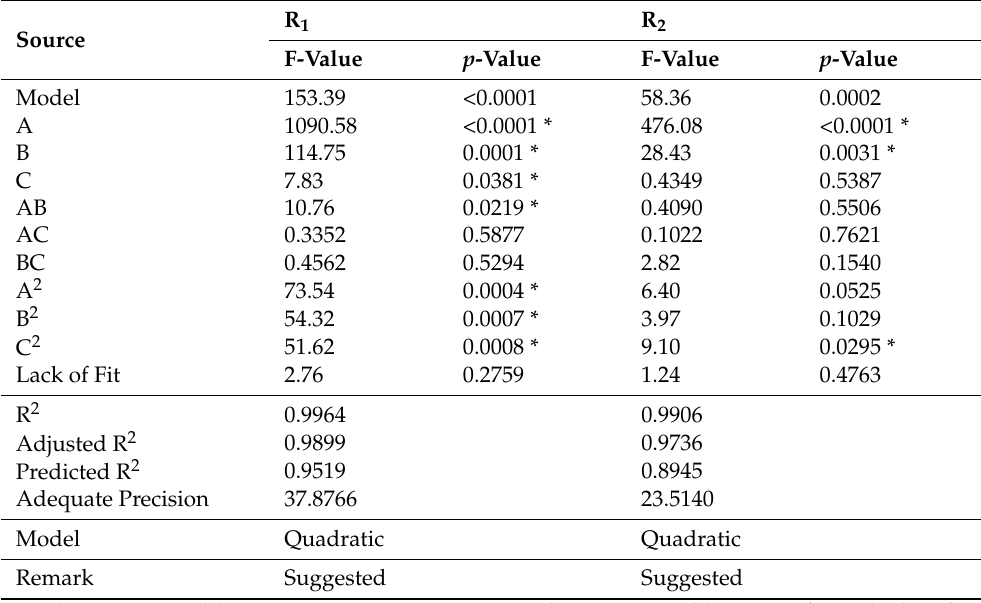
Table 3. Statistical analysis and fit statistics of all dependent variables R 1 and R 2